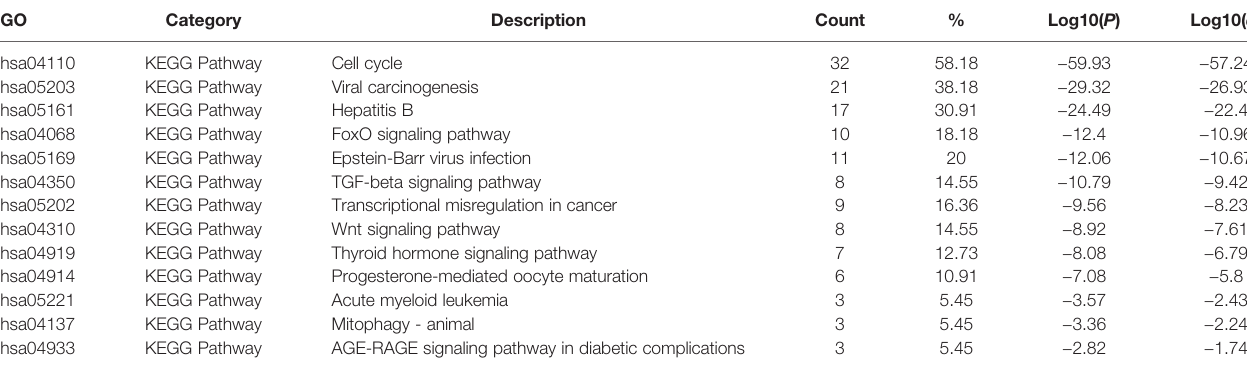
TABLE 3 | The KEEG function enrichment analysis of E2Fs and neighbor genes in PAAD (Metascape).